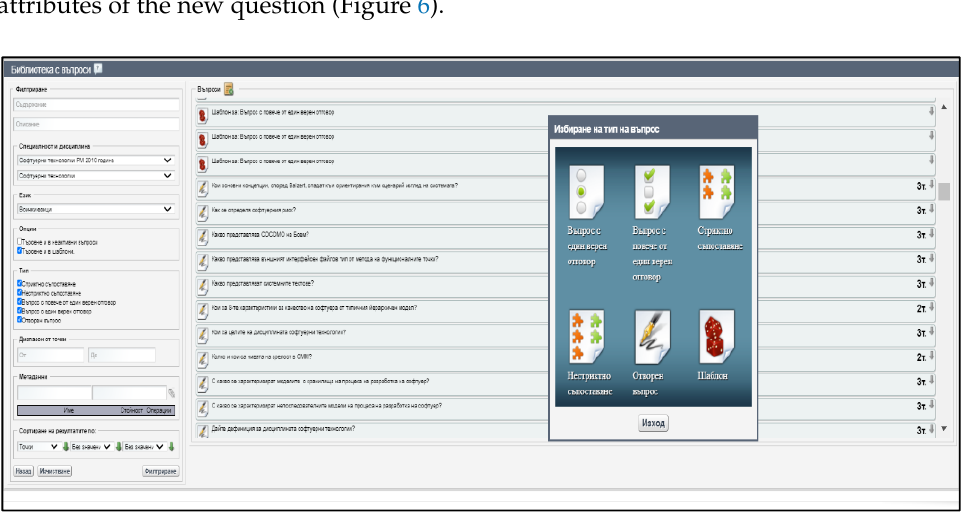
Figure 6. A Question Editor (in Bulgarian).